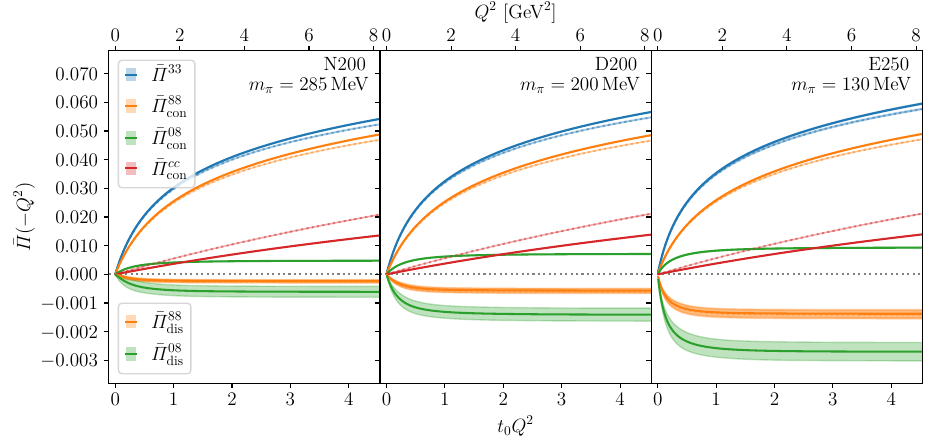
Figure 5 . Running with energy Q 2 of different contributions to ¯ Π ( − Q 2 ) on three different ensembles at a ≈ 0 . 064 fm . The conserved-local discretization is shown and, when available, the local-local discretization in a lighter color shade. The negative side of the vertical axis of the plot is inflated by a factor 10 with respect to the positive